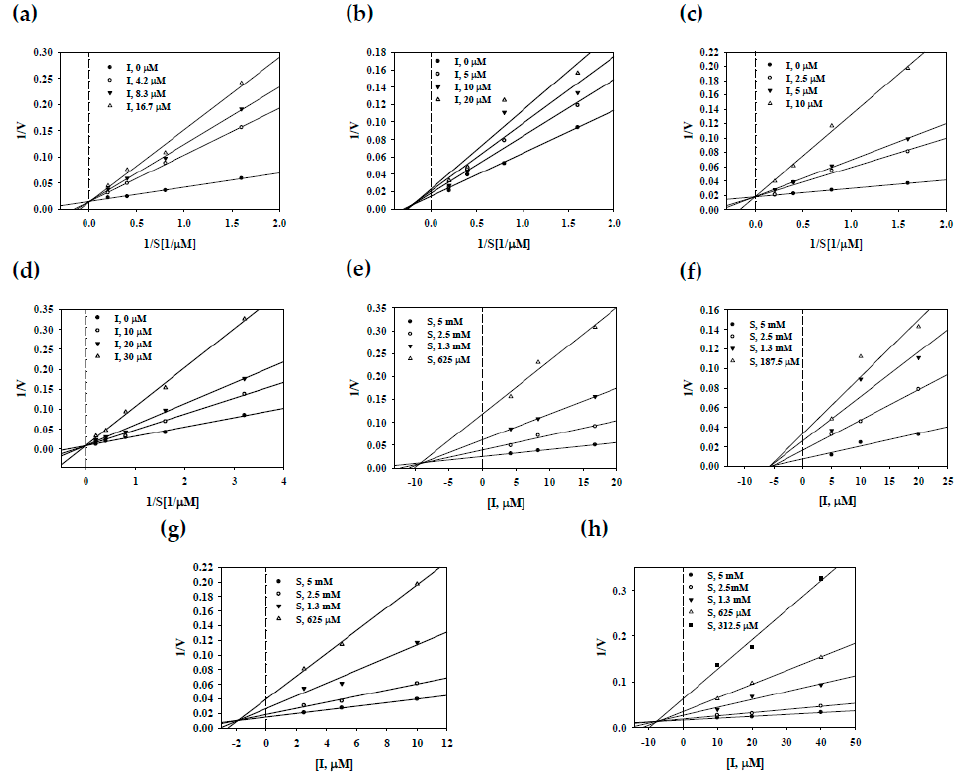
Figure 2. Lineweaver–Burk ( a – d ) and Dixon ( e – h ) plots of compounds 7 – 10 on sEH.